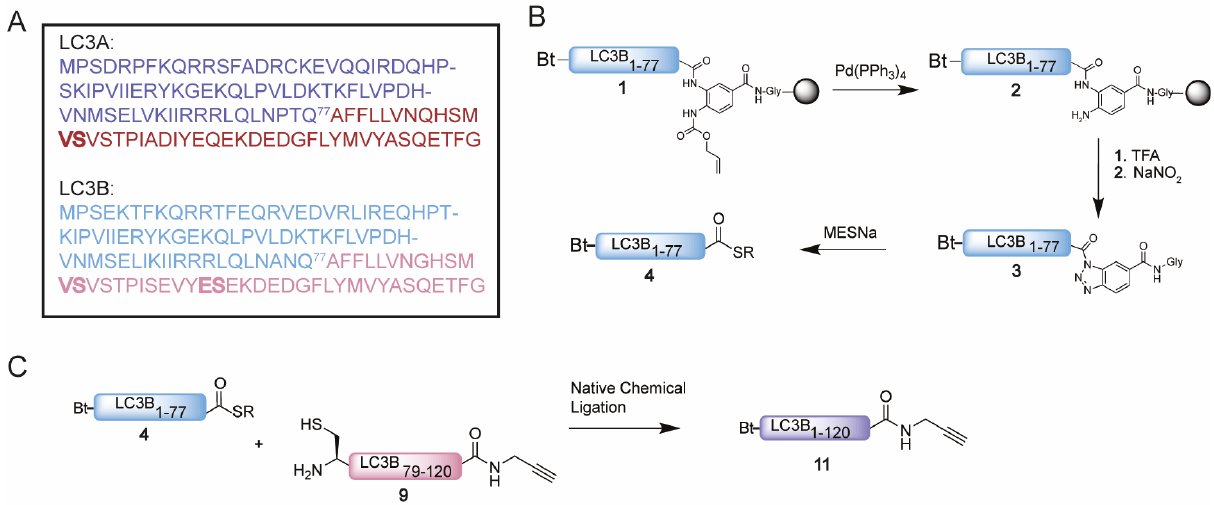
Figure 2. ( A ) Sequence of LC3A and LC3B with Gln77 as site of NCL and N-terminal peptide and C-terminal peptide in blue and magenta, respectively. Pseudoproline dipeptides introduced after automated fast fl ow peptide synthesis (AFPS) analysis are indicated in bold. ( B ) Schematic repre- sentation of the synthesis of thioester 4. ( C ) Schematic representation of the NCL reaction between thioester 4 and cysteine peptide 9 towards Bt-LC3B-propargylamide 11.